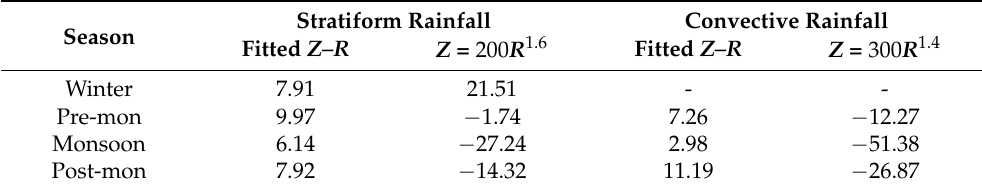
Table 7. NB (%) values of the fitted Z–R relationships and empirical relationships for different precipitation types in the four